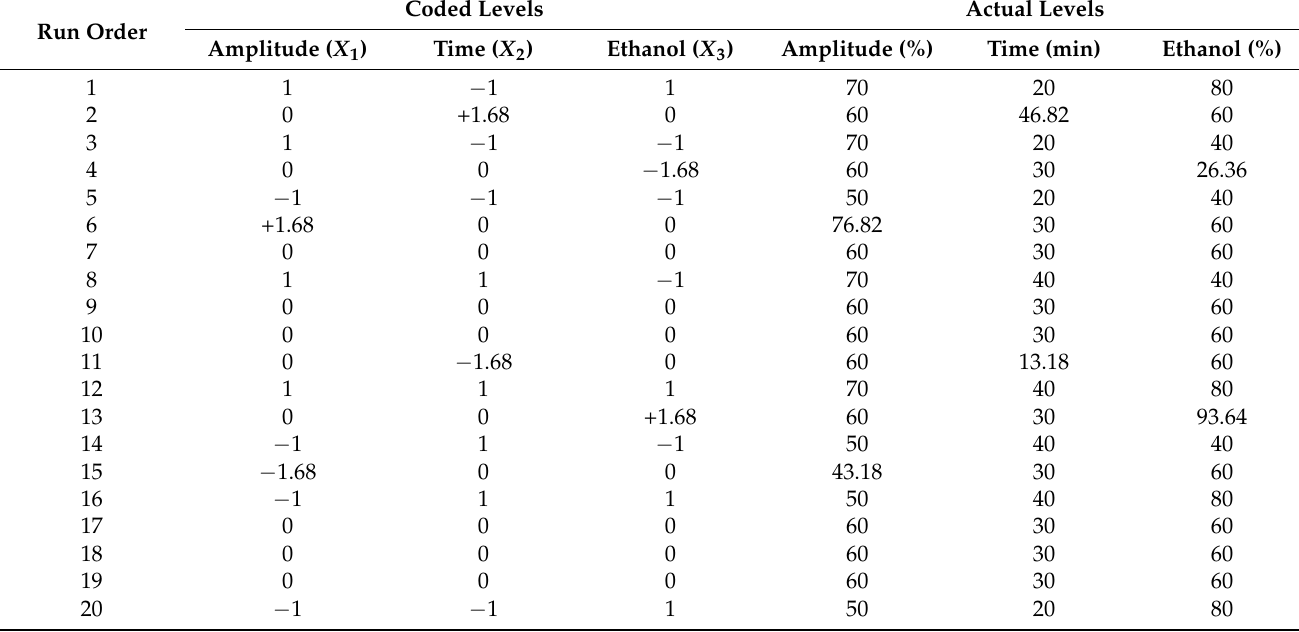
Table 1. Central composite design for extraction of